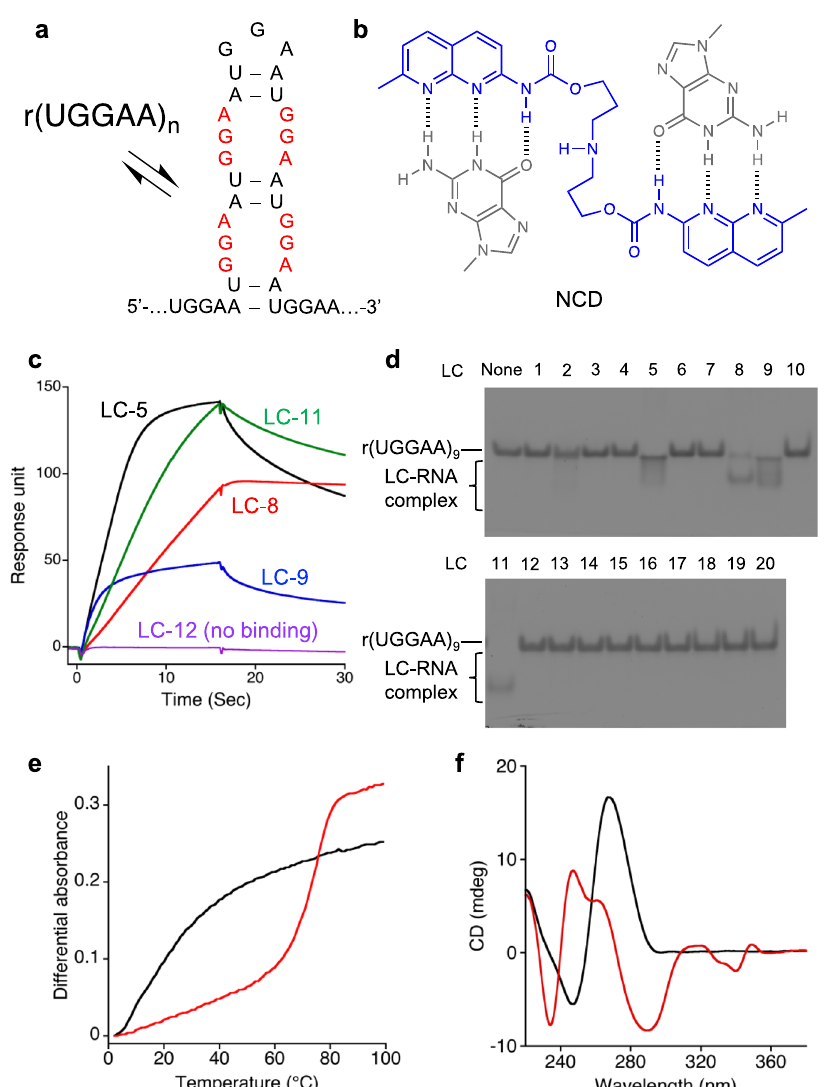
Fig. 1 Screening of r(UGGAA) n -binding small molecules from an in-house chemical library. a Possible hairpin structures in r(UGGAA) n containing internal loop with three consecutive G-A, G-G, and A-G mismatch base pairs (shown in red). b Chemical structure of NCD (shown in blue) and schematic illustration of hydrogen bonding to guanines (shown in gray). c Representative SPR data for the binding of LC-5 (black), 8 (red), 9 (blue), and 11 (green), and for the non-binding of LC-12 (purple) to r(UGGAA) 9 -immobilized surface. d Native PAGE analysis of interactions between LC-1 – 20 and r(UGGAA) 9 . e UV melting pro fi les and f CD spectra of r(UGGAA) 9 in the absence (black) and presence (red) of NCD. Source data are provided as a Source Data fi